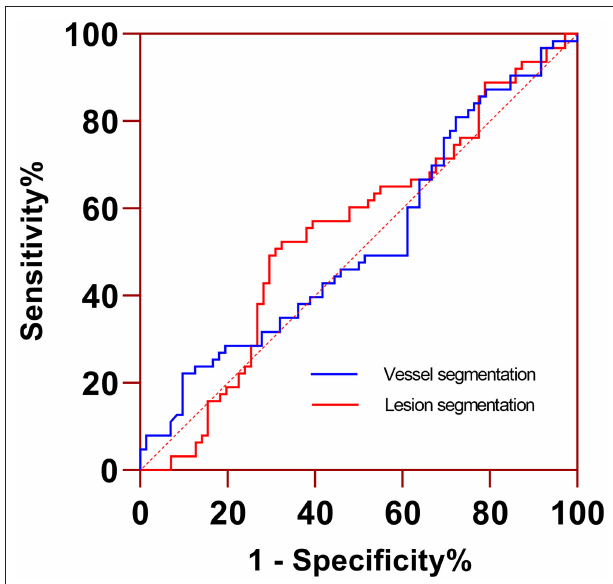
FIGURE 4 | ROC curve analysis of PCAT CT attenuation measured from lesion- and vessel-based segmentations for identifying functionally significant coronary stenosis. Two segmentations had similar AUC (0.547 vs. 0.524, p = 0.814). AUC, area under the curve; ROC, receiver operating characteristic curve.